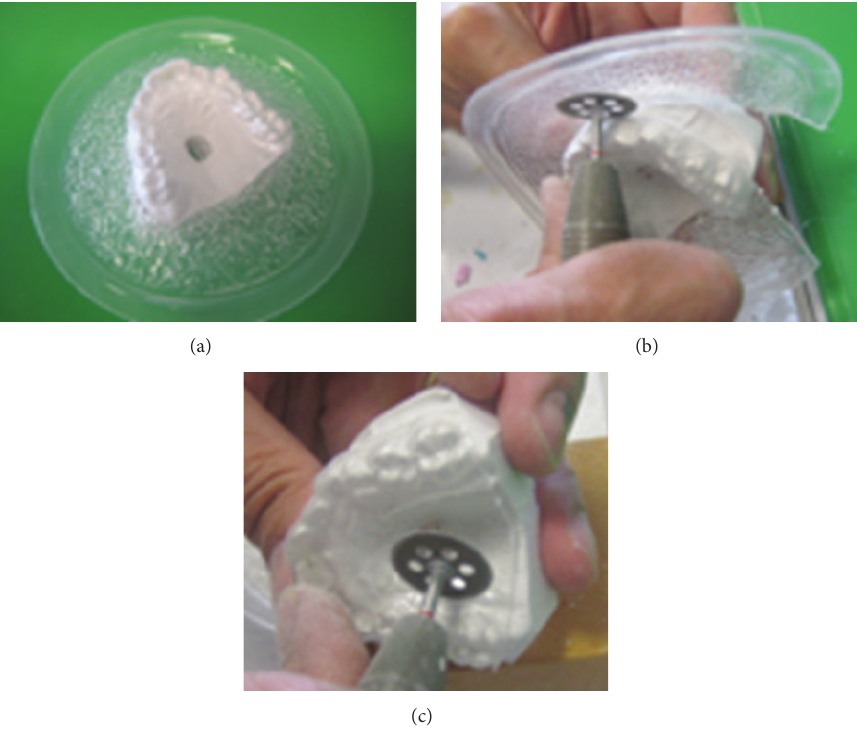
Figure 4: The appliance is cut out and the mucosal flange is reduced.